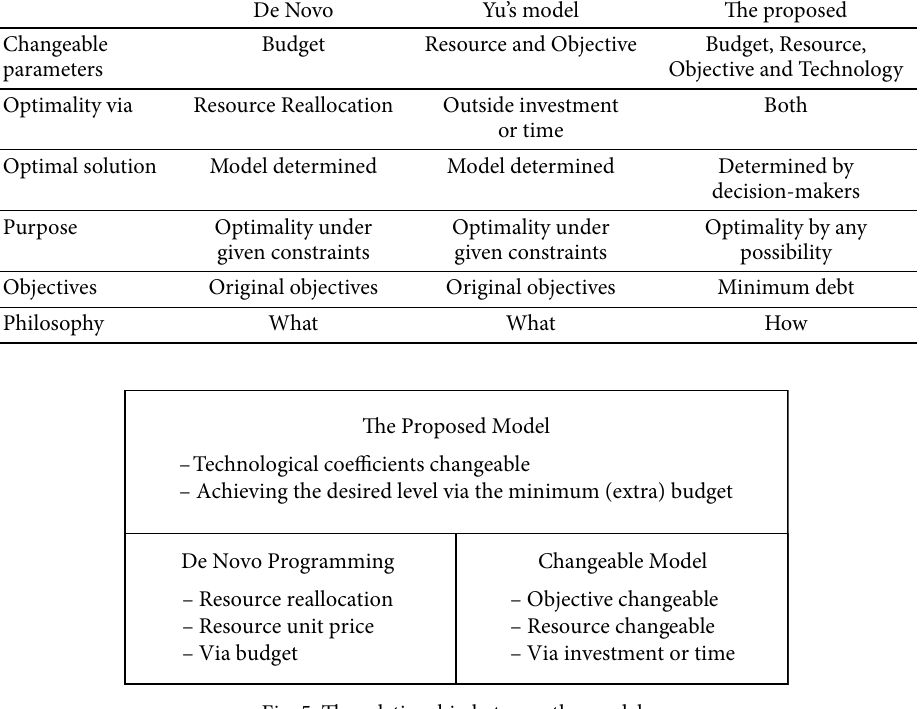
Fig. 5. The relationship between the